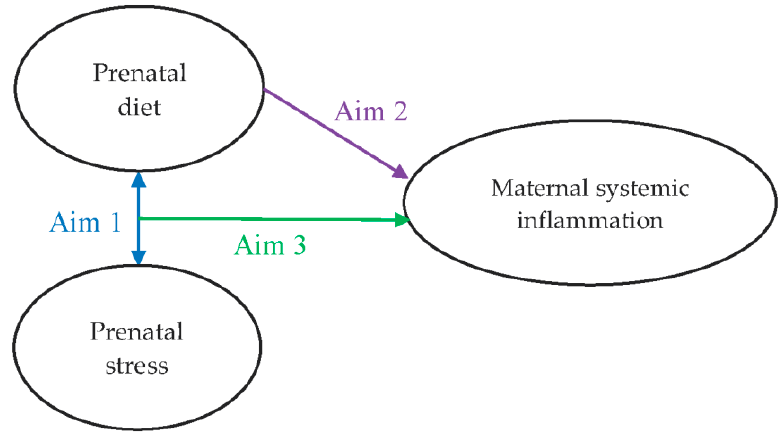
Figure 1. Hypothesized interaction between maternal prenatal diet and stress and the influence on systemic inflammatory profile in pregnancy.